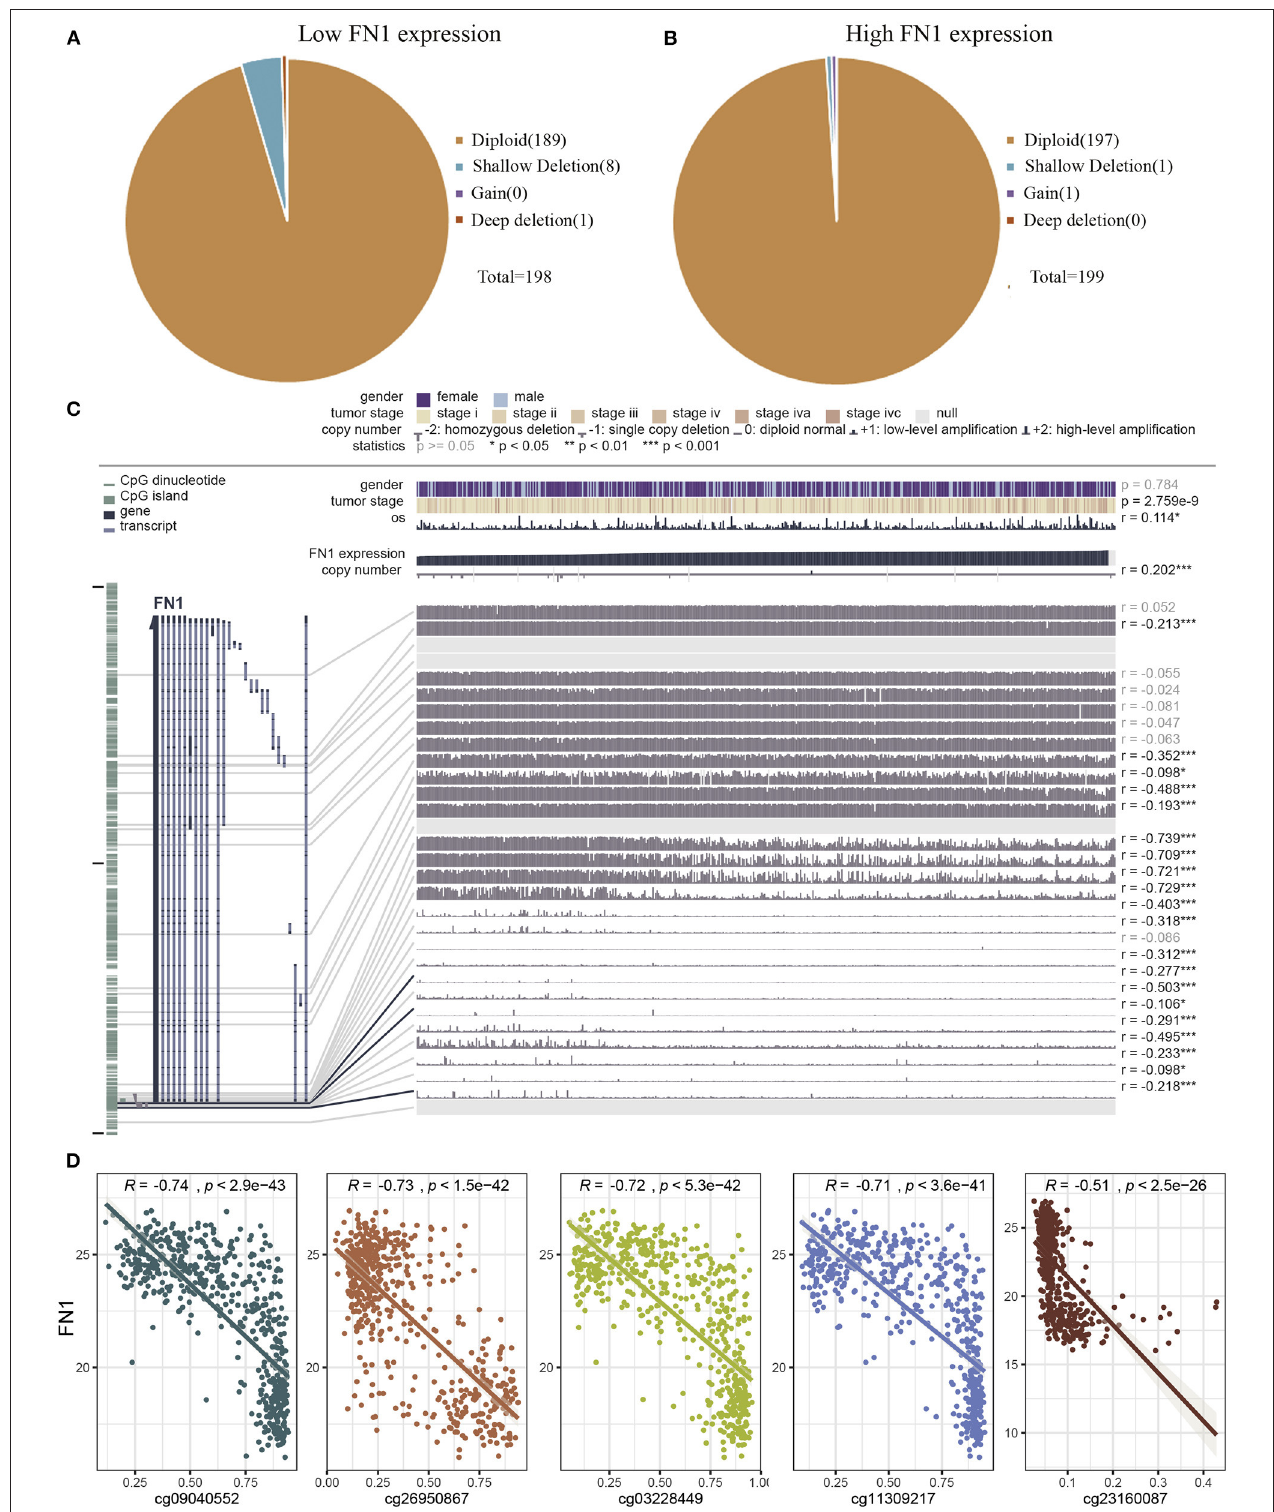
FIGURE 4 | Analysis of the potential genetic and epigenetic alterations associated with FN1 dysregulation. (A,B) The CNAs in FN1-high and low expression groups. (C) Analysis of CpG island methylation and abnormal FN1 expression using TCGA-THCA dataset. (D) Correlation between FN1 expression and CpG island methylation was performed. * p < 0.05, ** p < 0.01, *** p < 0.001.